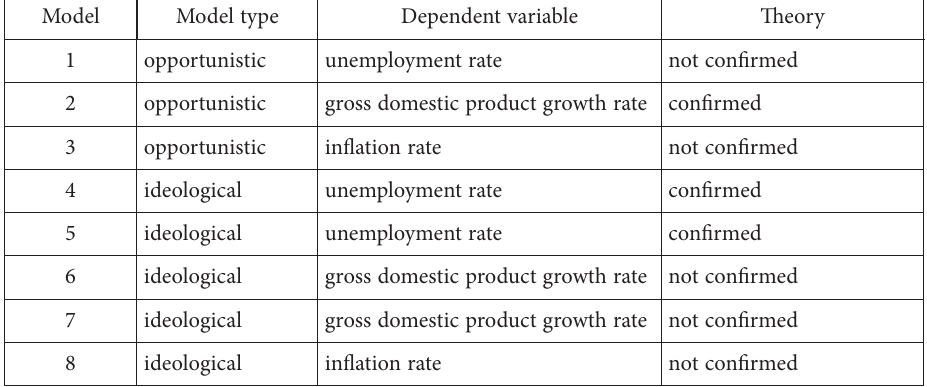
Table 3. Overview of the regression